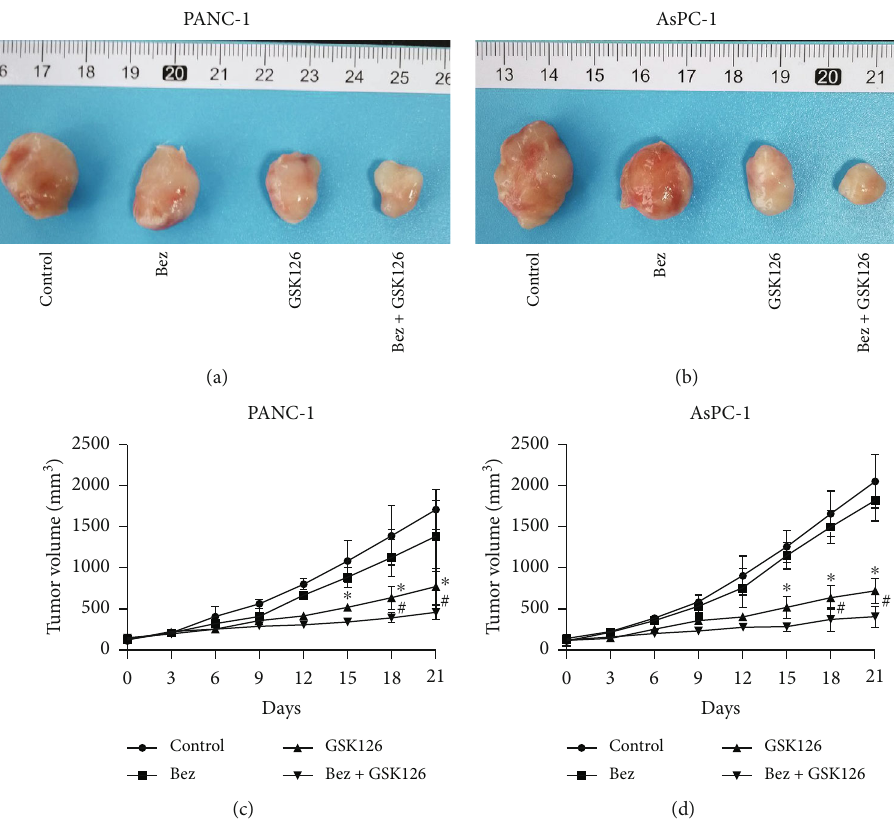
Figure 5: E ff ects of combination of beza fi brate and GSK126 on CDX tumor volumes. (a) Representative image of bearing tumors of PANC-1 in each experimental group. (b) Representative image of bearing tumors of AsPC-1 in each experimental group. (c) Growth curves of bearing tumors of PANC-1 in each experimental group. (d) Growth curves of bearing tumors of AsPC-1 in each experimental group. The values were expressed as the means ± S : E : M : ( n = 6 for each group). ∗ P < 0 : 05 vs. control; # P < 0 : 05 vs. the GSK126